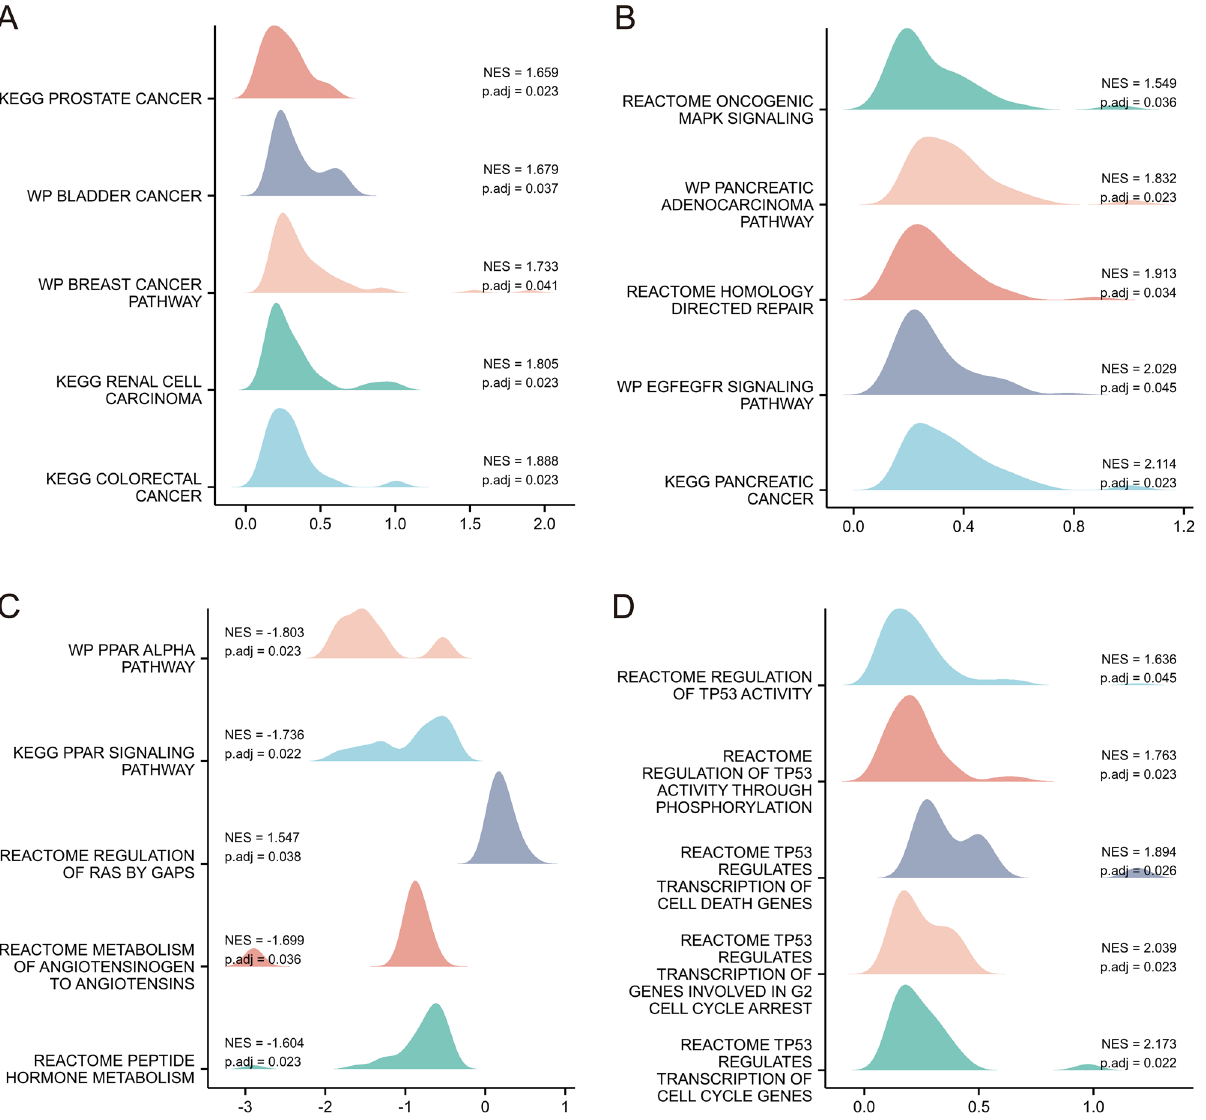
Figure 4. Plots of enrichment derived from the analysis of gene set enrichment (GSEA). ( A–D ) p. adj adjusted P-value, ES enrichment score, NES normalized